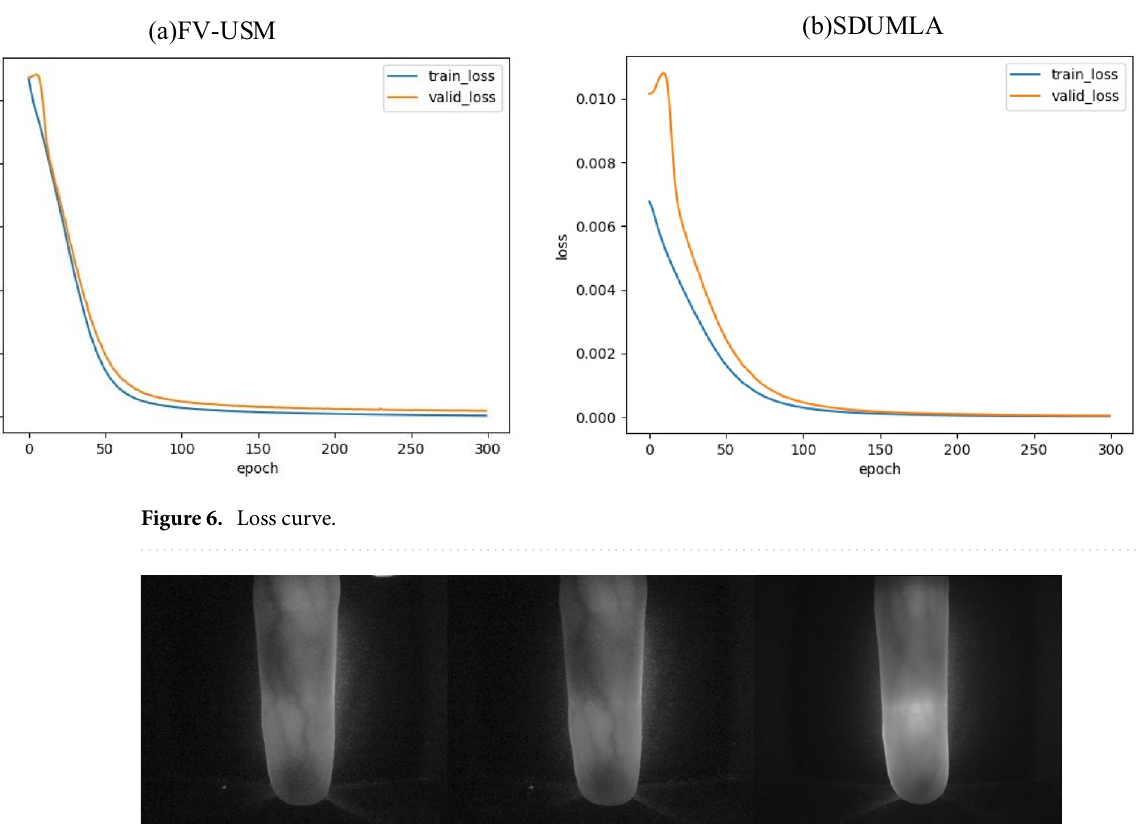
Figure 7. Poor quality images in public